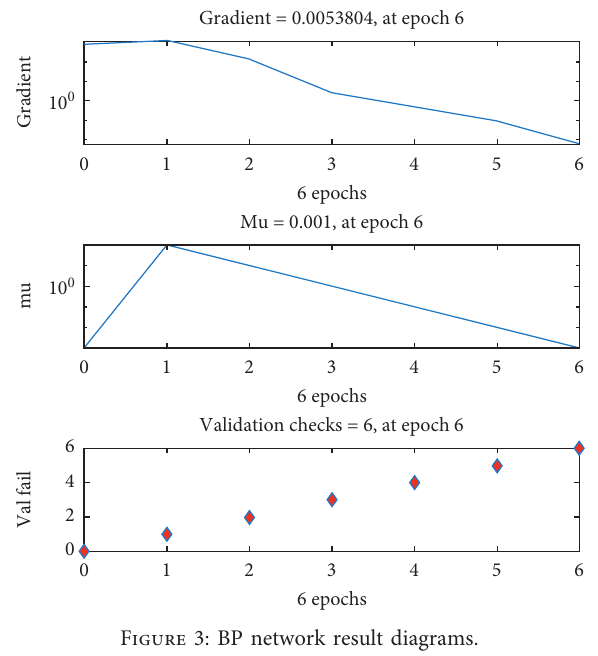
Figure 3: BP network result diagrams.